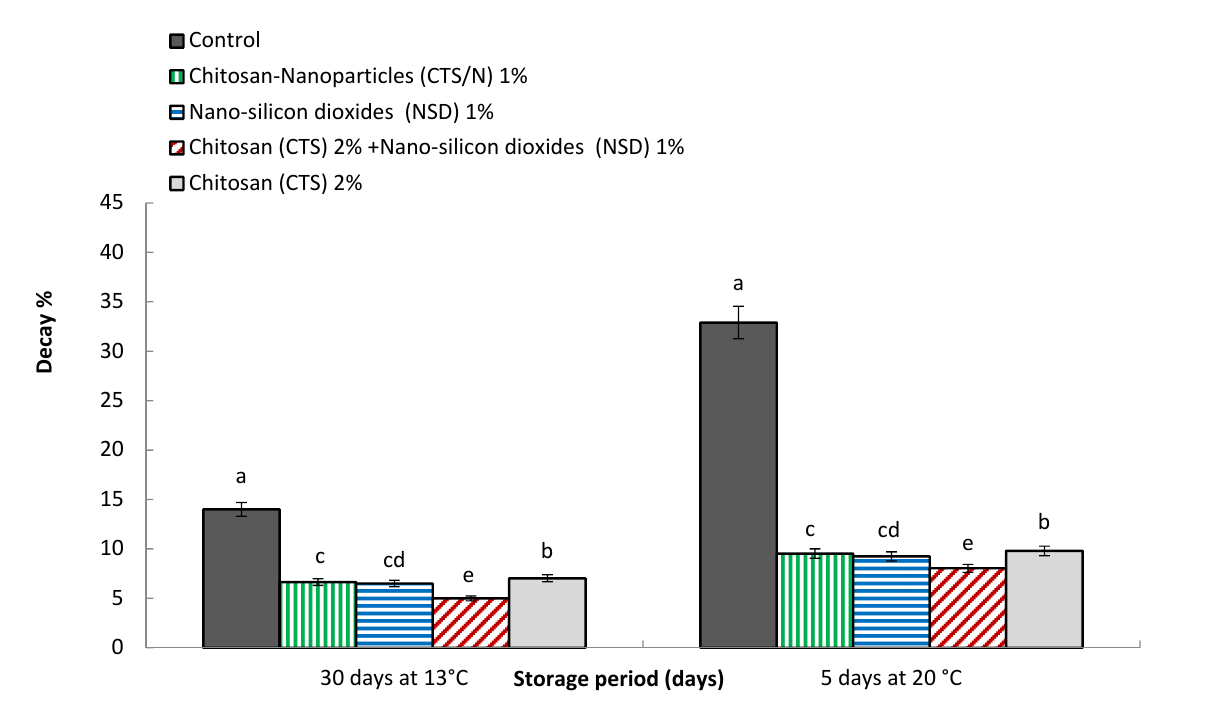
Figure 2. Decay percentage as a mean of ‘Tommy Atkins’ mangoes from two seasons, stored at 13 ± 1 °C and 90–95% RH for 30 days. Afterward, the fruits were stored at 20 ± 2 °C and 70–75% RH for 5 days as the marketing period. Vertical bars indicate the standard error (SE) of the mean ( n = 5). The superscript letters followed by the same letters are not significantly different according to Duncan’s multiple range test at 0.05 level.